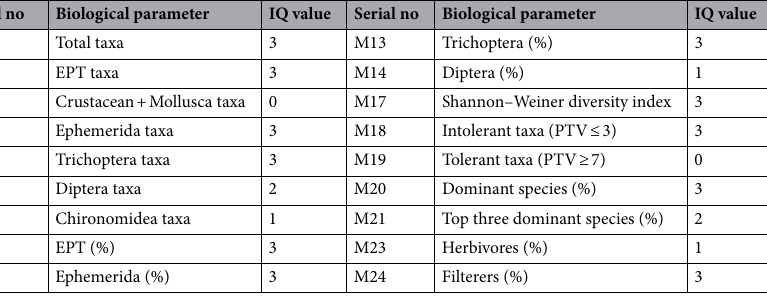
Table 2. Degrees of overlapping between the reference sites and the impaired sites in terms of the candidate